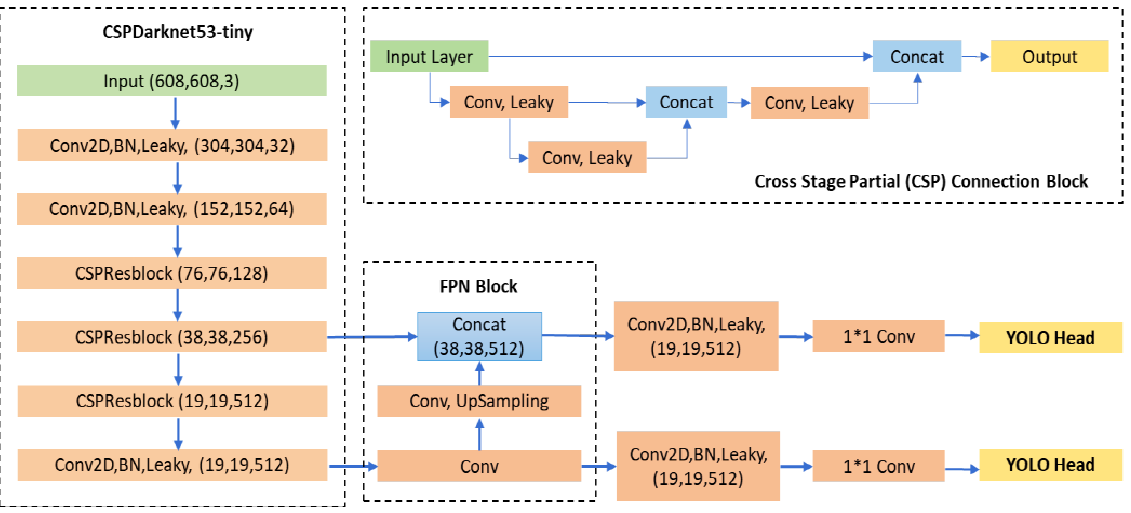
Figure 1. Example YOLO network structure (YOLOv4-tiny).